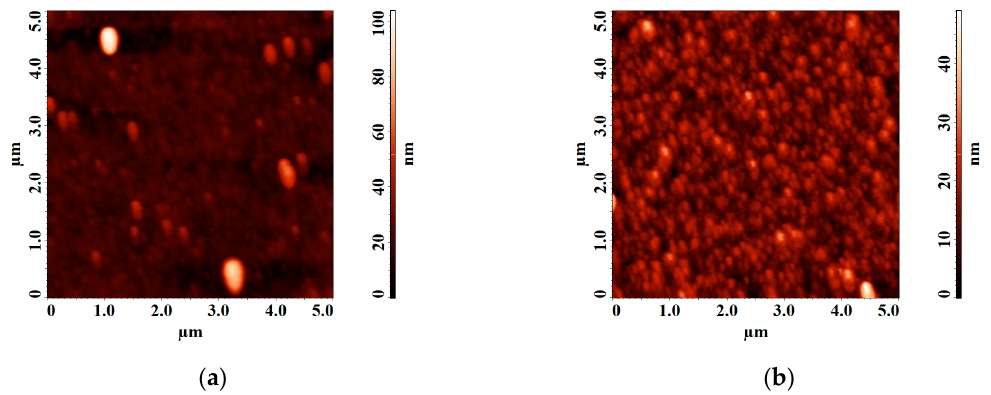
Figure 7. Atomic force microscopy (AFM) images of LiNbO 3 film grown by pulsed laser deposition (PLD) at different oxygen pressures: 1 × 10 − 5 Torr ( a ), 1 × 10 − 2 Torr ( b ).